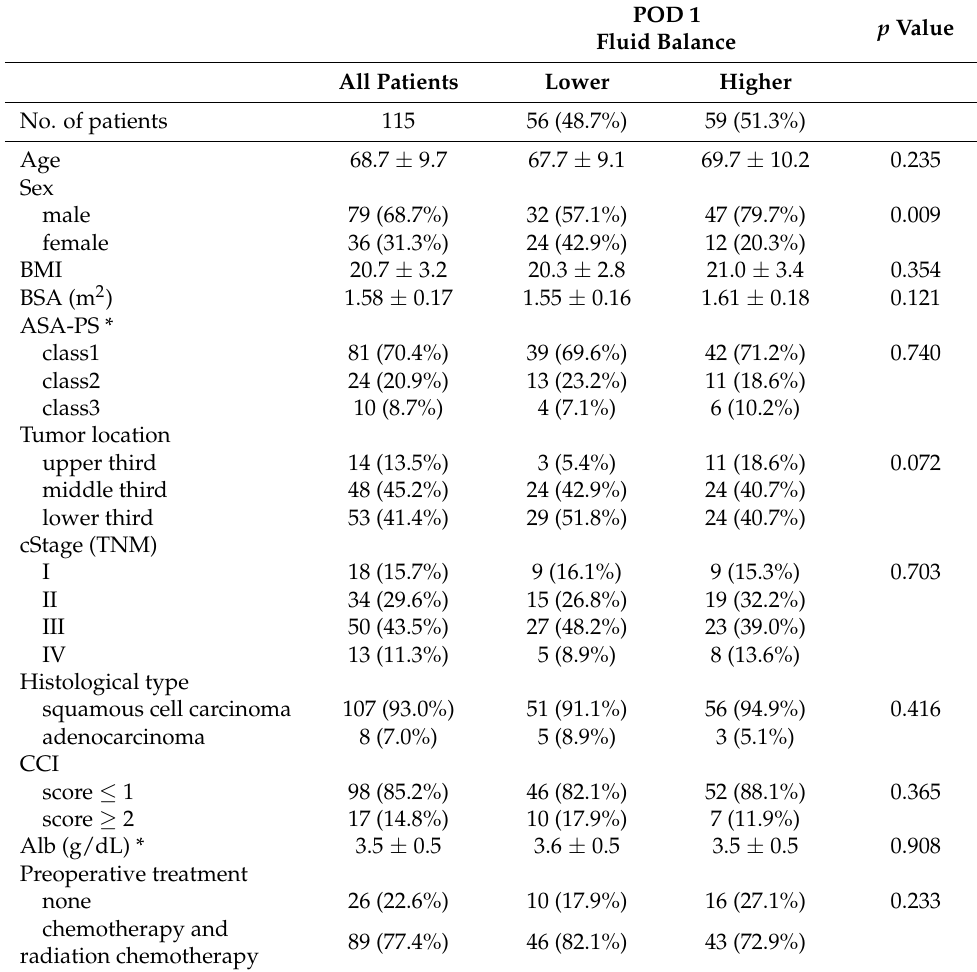
Table 2. Characteristics of the patients in POD1 fluid balance.